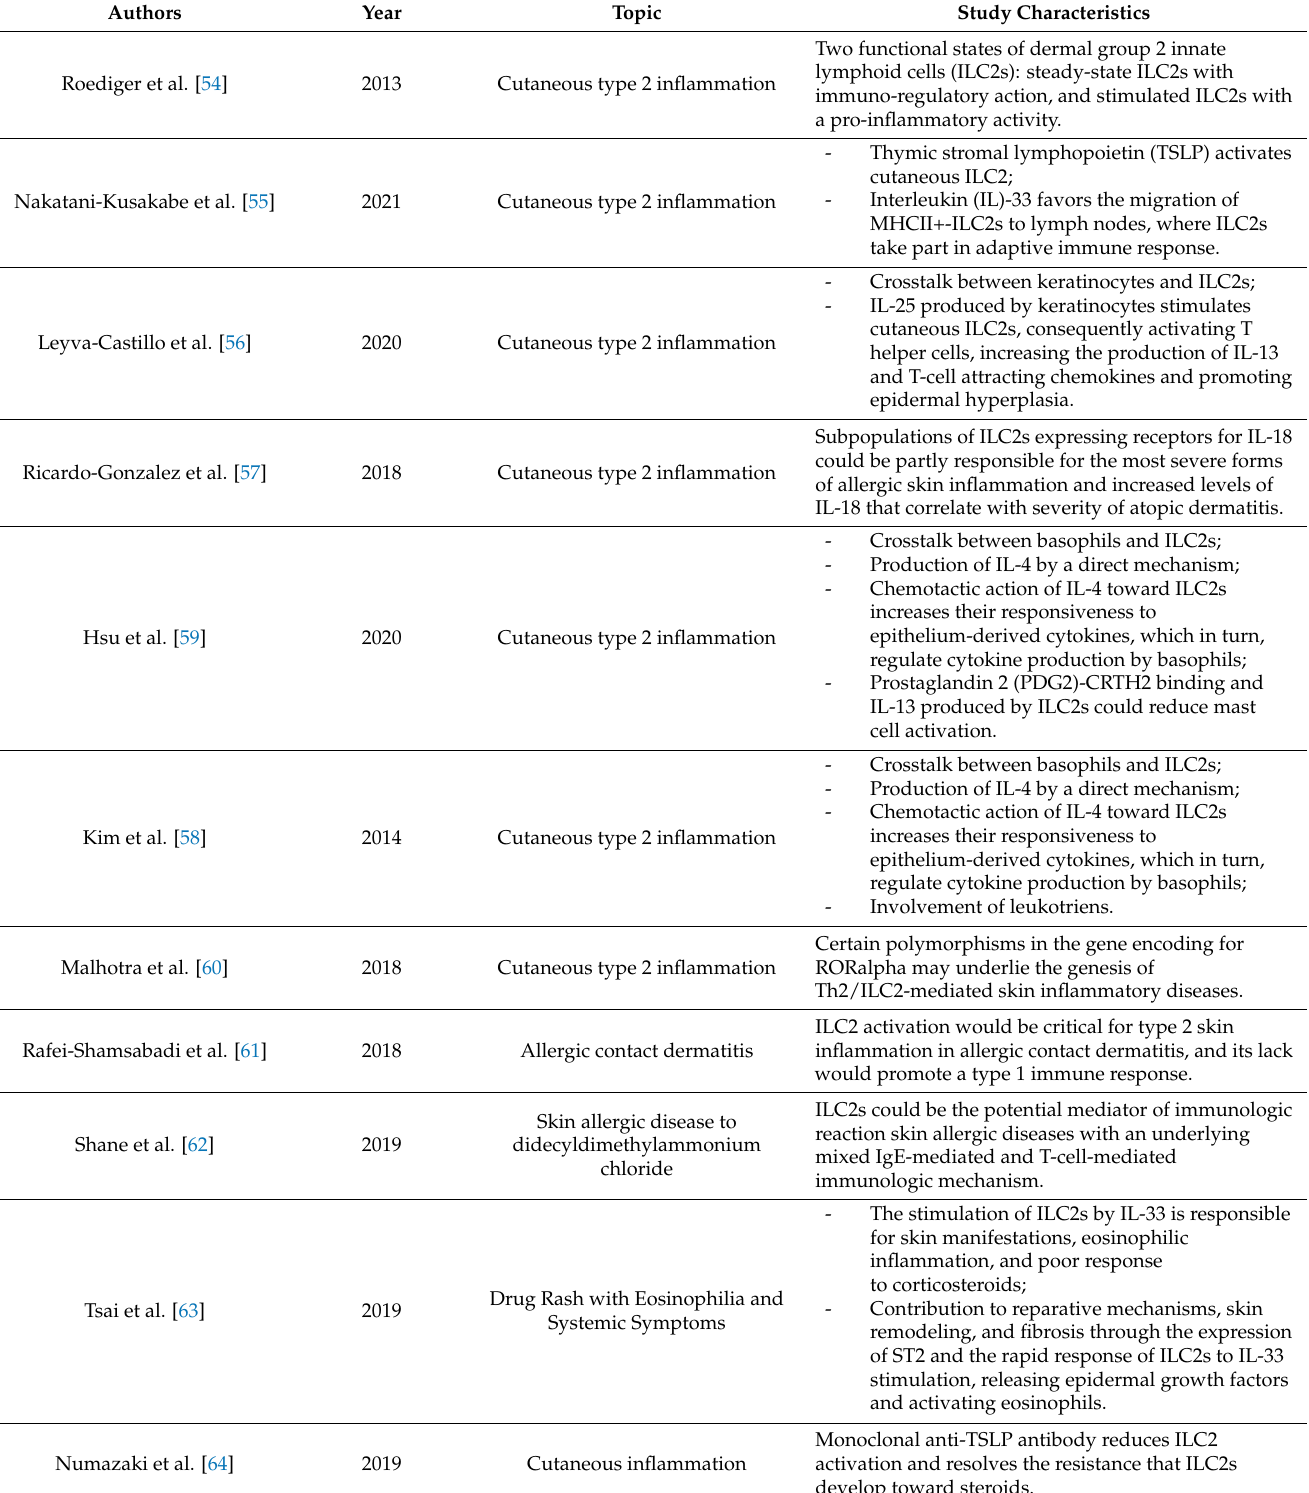
Table 2. The main findings about the role of ILC2s in allergic cutaneous